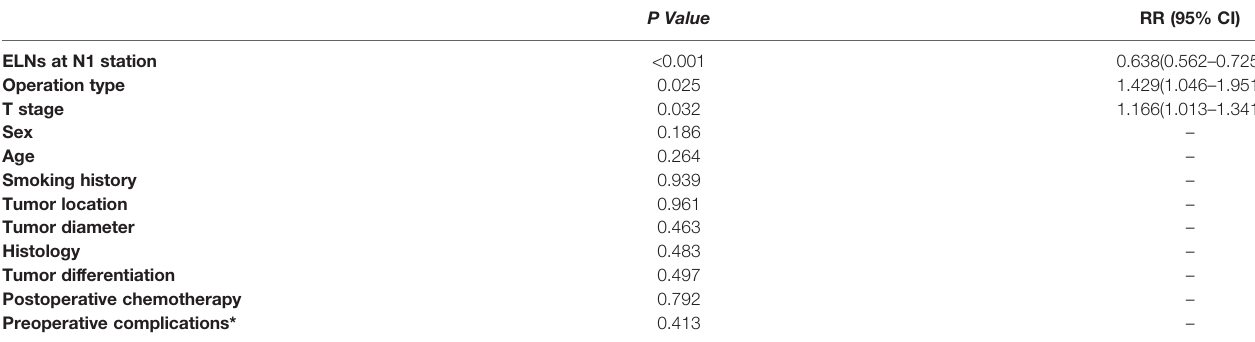
TABLE 3 | The prognostic factors associated with overall survival of patients in groups A, B, and C by multivariate Cox